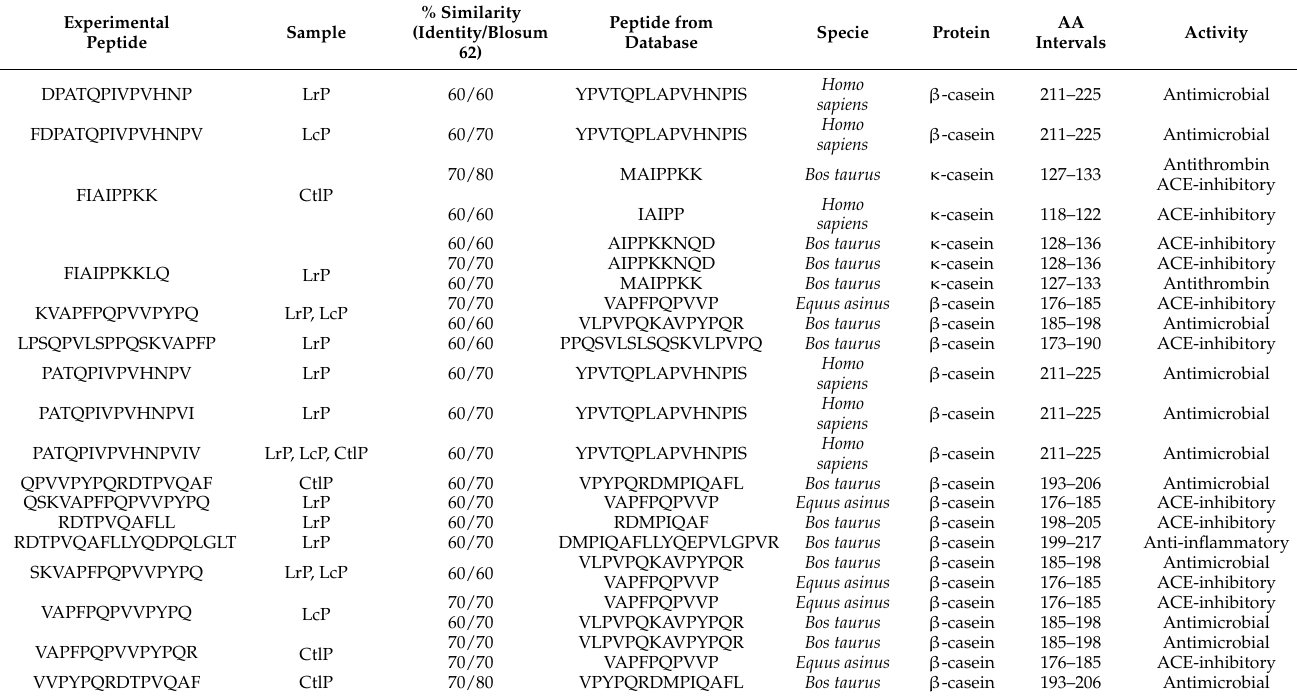
Table 2. List of the peptides from donkey milk inoculated with L. rhamnosus 17D10 (LrP), L. lactis subsp. cremoris 40FEL3 (LcP), and not inoculated (CtlP) showing at least 60% of similarity (identity as scoring matrix) to the bioactive peptides present in the Milk Bioactive Peptide Database